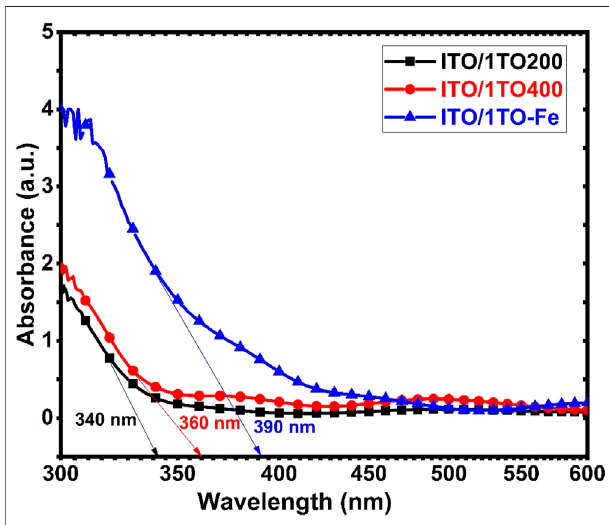
FIGURE 4 | UV – visible absorption spectra for different TiO 2 thin fi lms on ITO